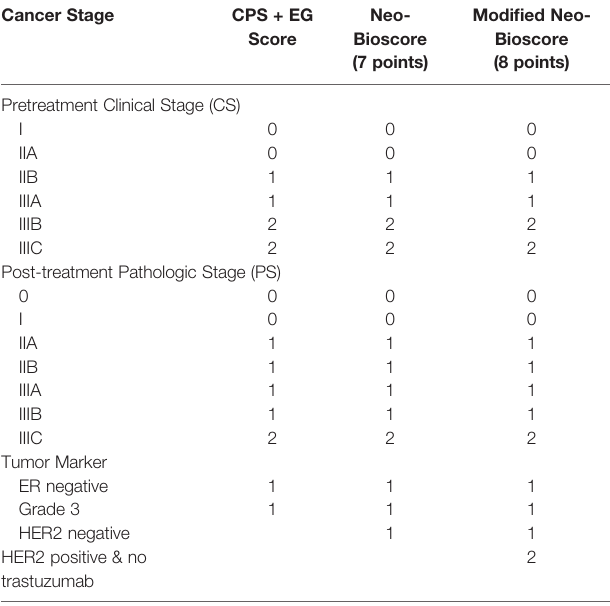
TABLE 1 | Point Assignment for the CPS + EG, Neo-Bioscore, and Modi fi ed Neo-Bioscore Staging